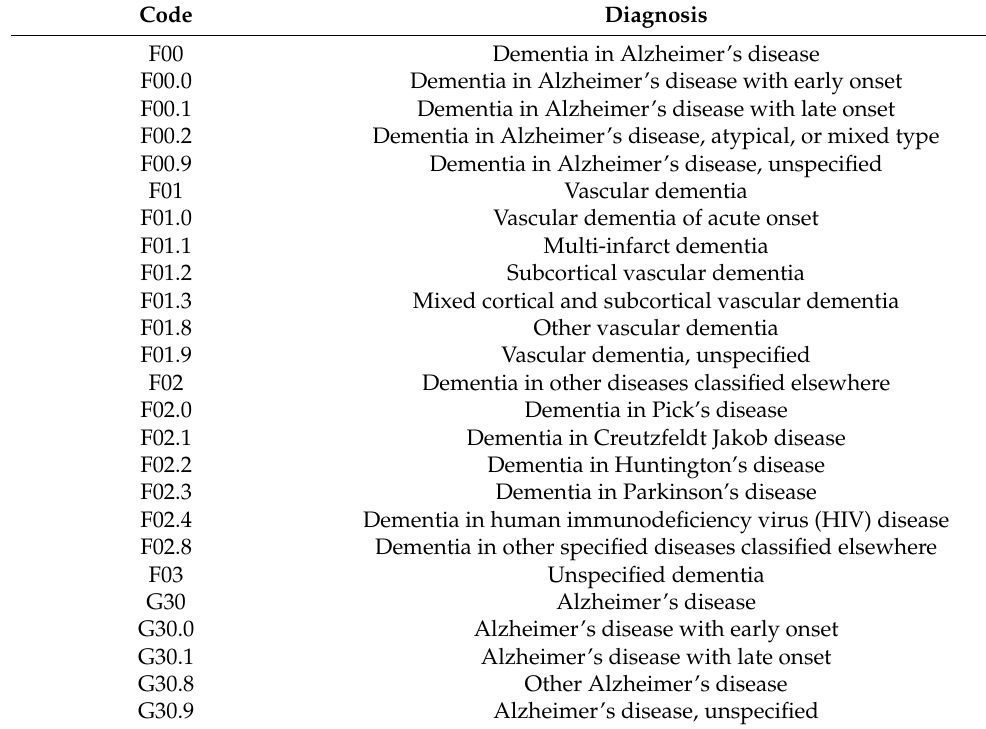
Table 1. Dementia classification code.